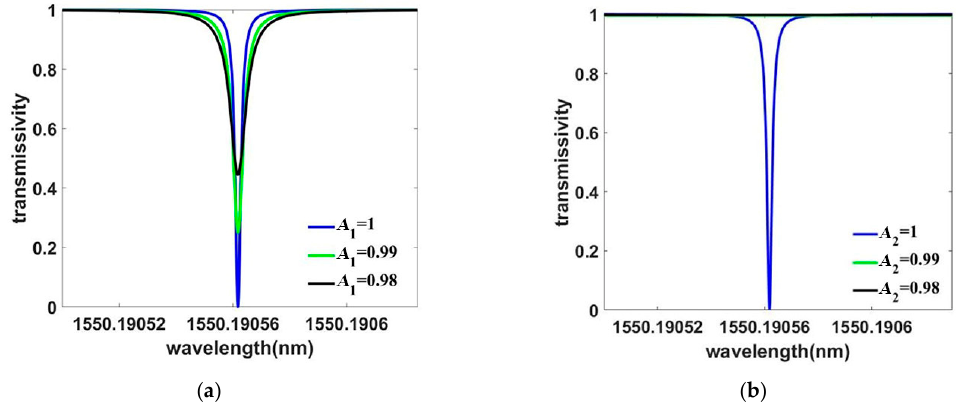
Figure 7. ( a ) The transmissivity of the double ring resonator at di ff erent wavelengths and the fi eld a tt enuation of outer ring ( 𝐴 (cid:2869) ) and ( b ) the transmissivity of the double ring resonator at di ff erent wavelengths and the fi eld a tt enuation of inner ring ( 𝐴 (cid:2870) ). Both are calculated at 𝑘 (cid:2869) = 𝑘 (cid:2870) = 𝑘 (cid:2871) = 0.1 . When it meets the critical coupling condition, the output power of the through port drops to zero. At this time, the relationship between transmission coe ffi cient and transmission loss is shown in Equation (11).